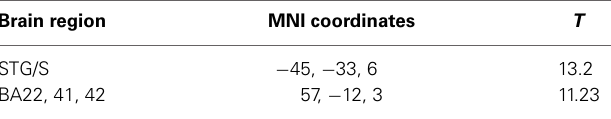
Table 6 | AV-VO. Brain region